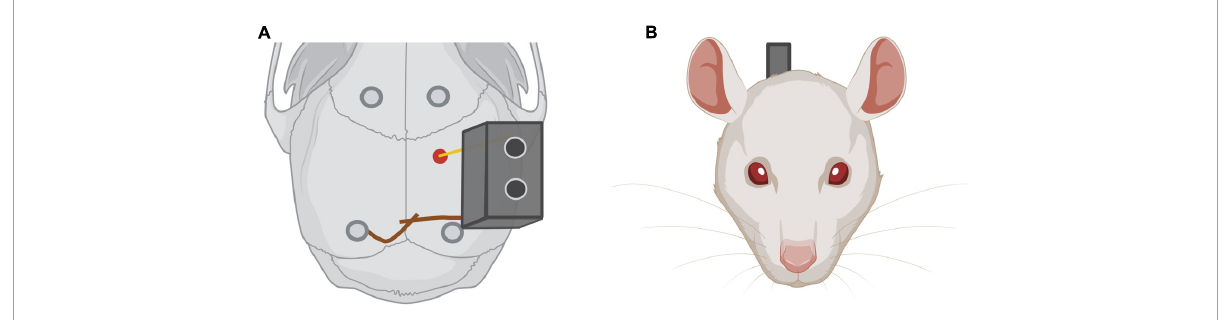
FIGURE7 (A) Electrode implantation. In red, electrode implantation position in the rat skull. Note in dark gray the four screws implanted in the skull to improve the adhesion of the implant. The ground screw is implanted in the contralateral hemisphere regarding the electrode and near Lambda. (B) Rat frontal view with the electrode